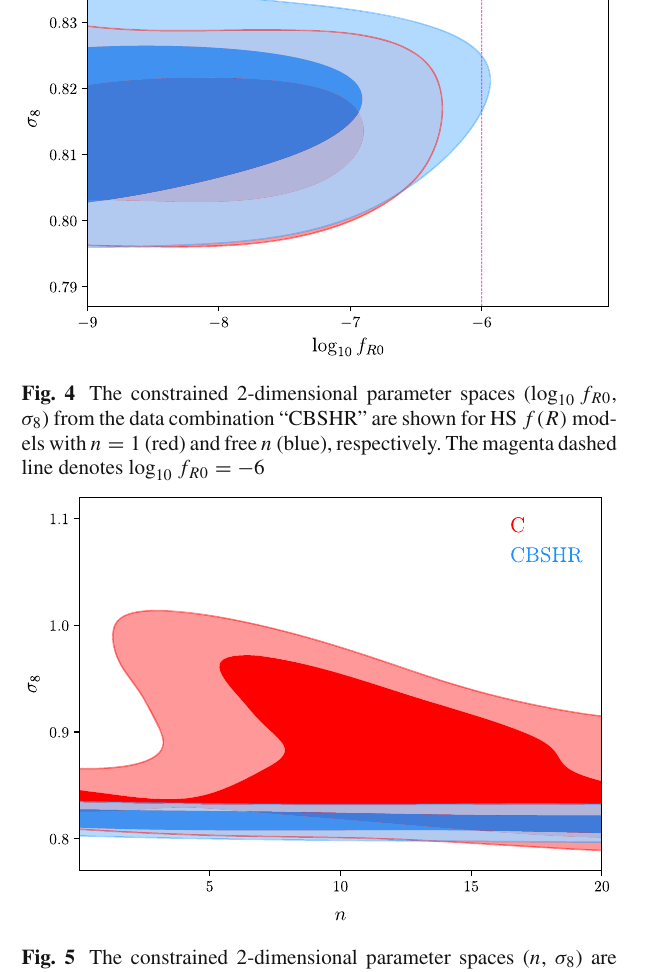
Fig. 5 The constrained 2-dimensional parameter spaces ( n , σ 8 ) are shown for HS f ( R ) model with free n by using the “C” (red) and “CBSHR” (blue) datasets,